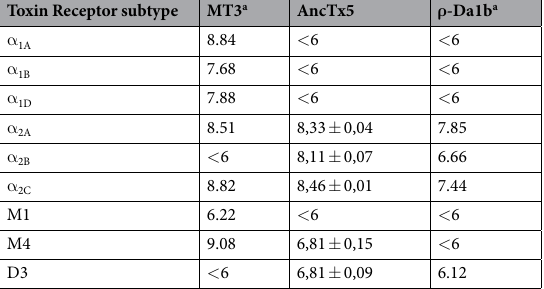
Table 2. Affinity constant (pKi ± SEM) of MT3, ρ -Da1b and AncTx5 toxins for muscarinic (M1,